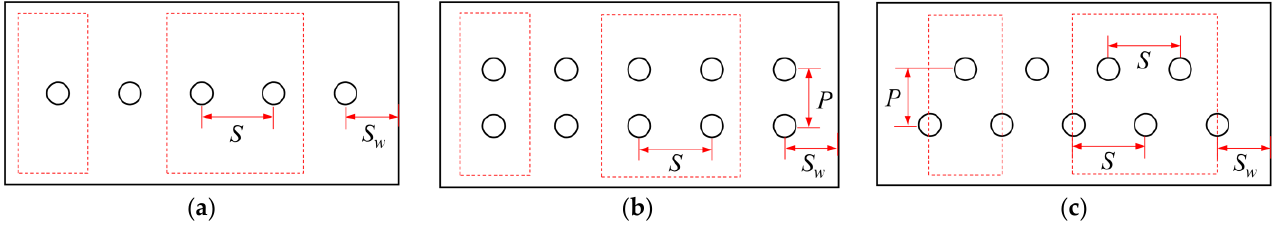
Table 3. Mechanical properties of unidirectional GFRP laminate [21].